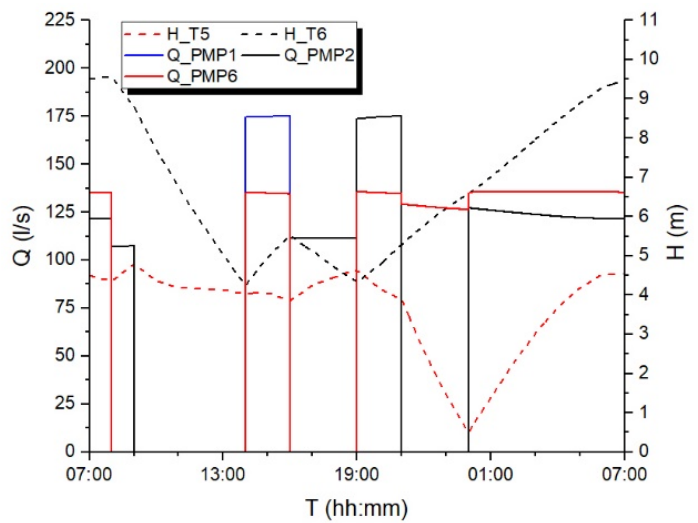
Figure 8. Results of the proposed pump scheduling methodology for Van Zyl network, hydraulic time-step 10 s.